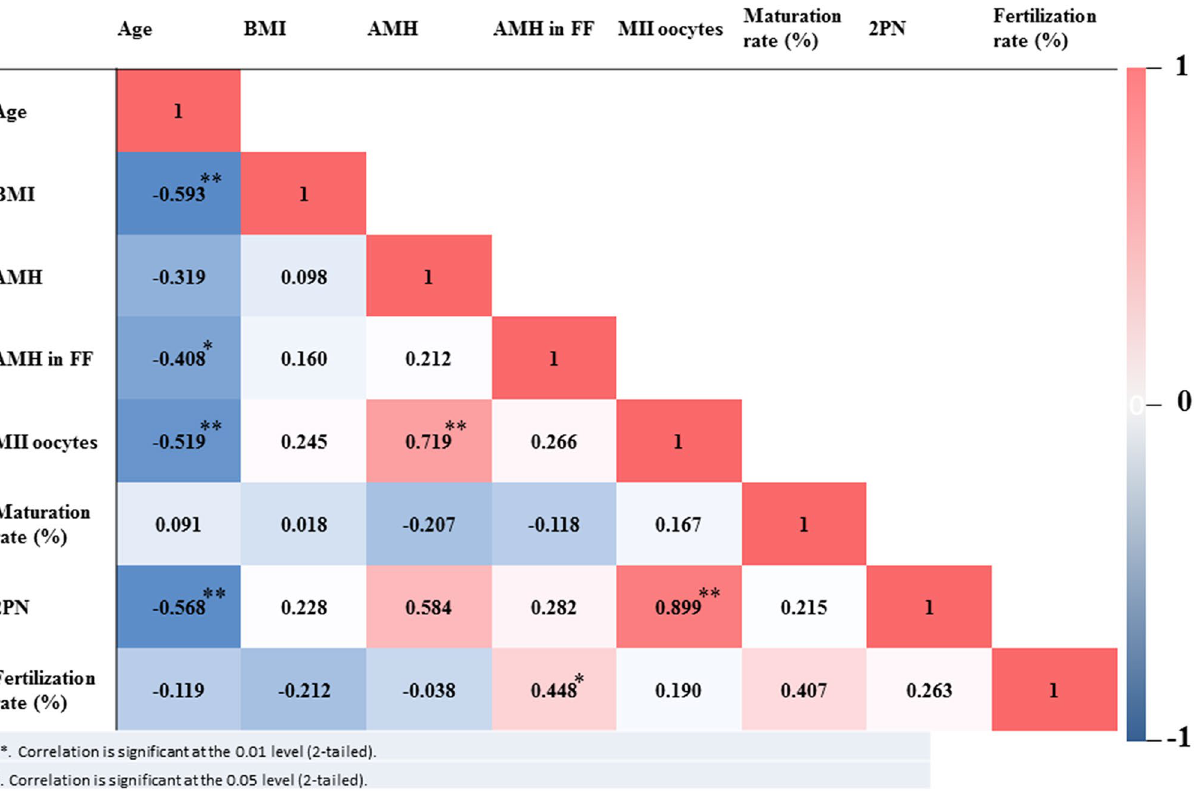
Figure 2. Heatmap showing the correlation coefficients between characteristics and ovarian response of participants. The heatmap was created in Excel (Microsoft 365) by using conditional formatting. Dark red, high correlation (near 1); dark blue, high anti-correlation (near − 1); *p < 0.05; **p < SCF (area under ROC curve, 0.706; 95% confidence interval, 0.491–0.921; p = 0.087) were the best predictors of oocyte maturity. At an optimal cut-off value of 16 ng/mL, leptin had the best power of positive predictive value (sensitivity) up to 70% and negative predictive value (specificity) of 91% for indicating oocyte maturity. Our findings concluded that the concentration of leptin in follicular fluid is closely related to ovarian reserve and